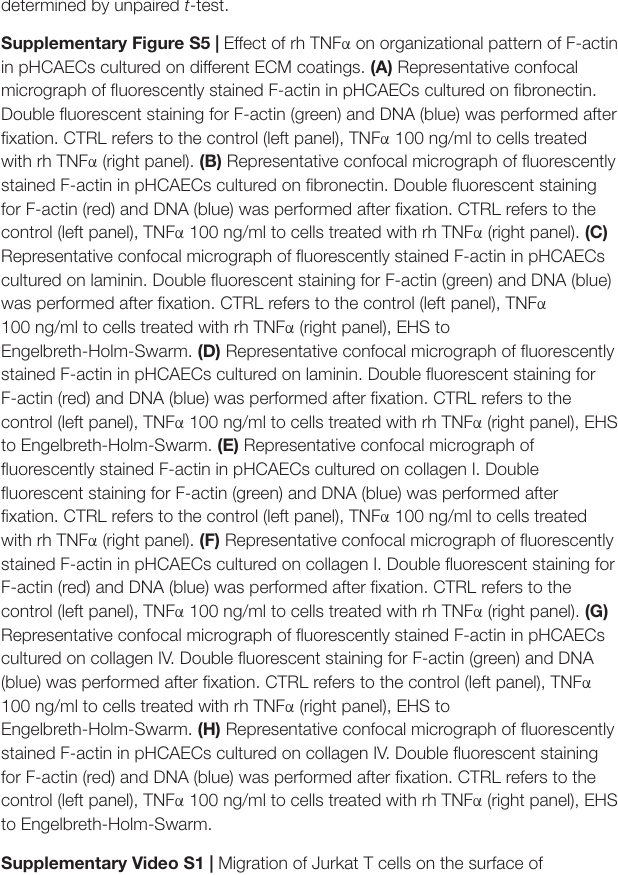
Supplementary Figure S1 | TNF α -induced expression of E-selectin in pHCAECs. Triple fluorescent staining for E-selectin (green), F-actin (red), and DNA (blue) was performed after fixation. CTRL refers to the control (top panel), TNF α 100 ng/ml to cells treated with rh TNF α . Supplementary Figure S2 | TNF α -induced expression of VCAM-1 in pHCAECs. (A) Representative micrographs of intravital detection of VCAM-1 using magnetic